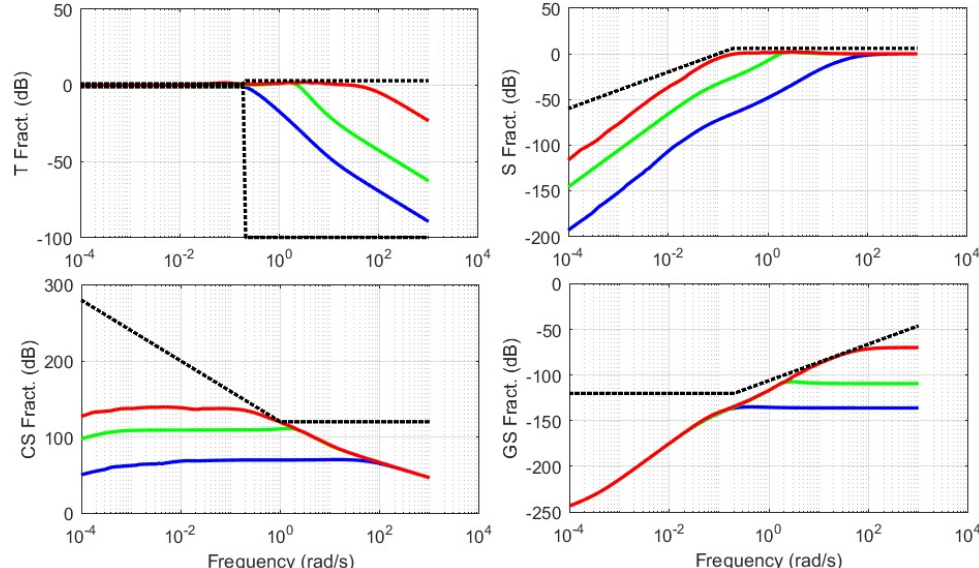
Figure 8. Gain diagram of the four sensitivity functions (solid line, green for the nominal behaviour, red and blue for two extreme behaviours of the plant) and user defined constraints (dotted lines).